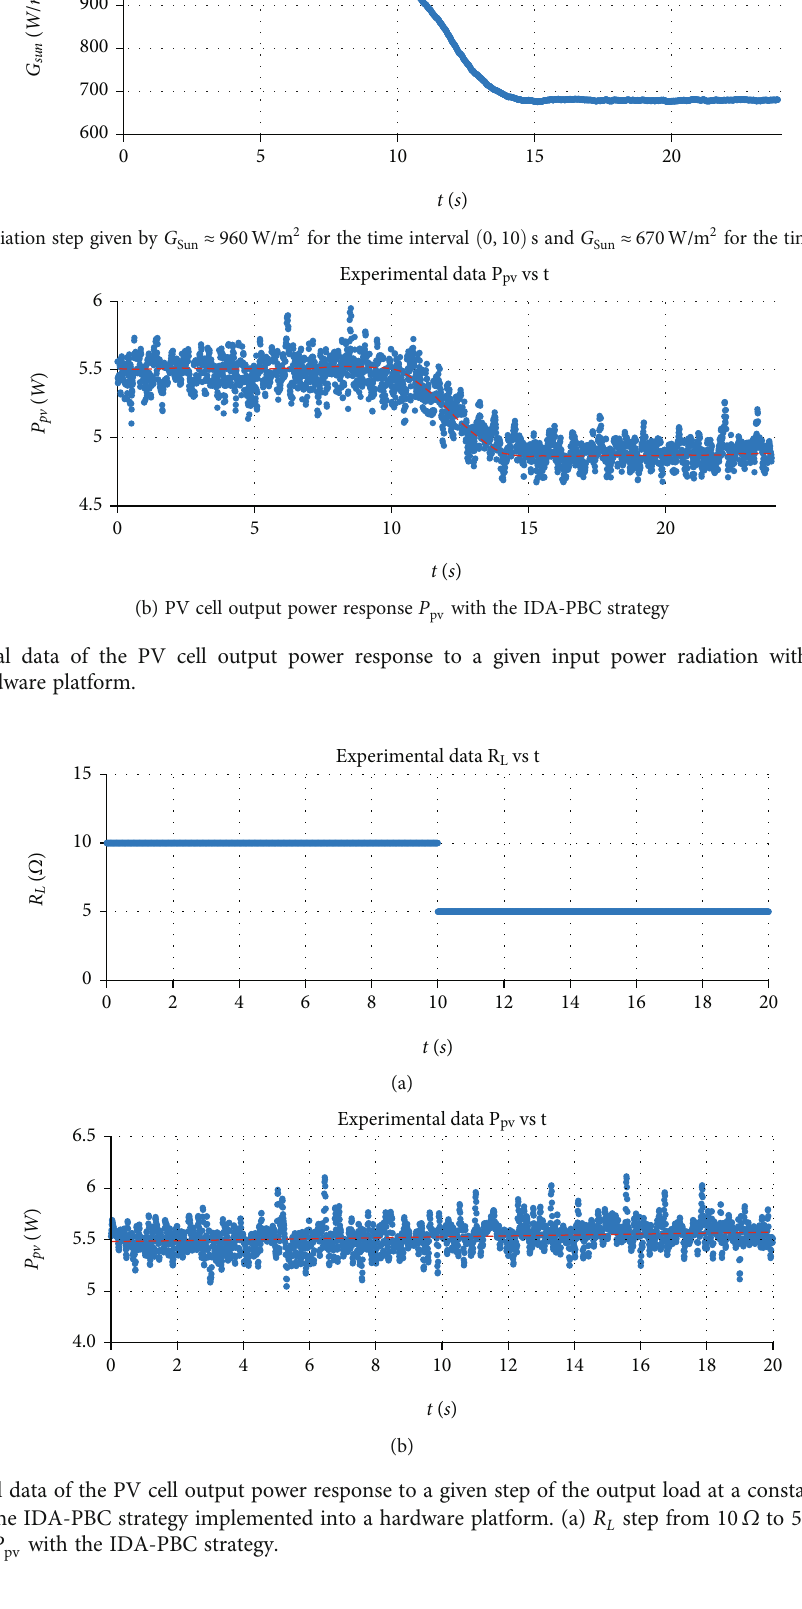
step from 10 Ω to 5 Ω at t = 10s . (b) PV cell L